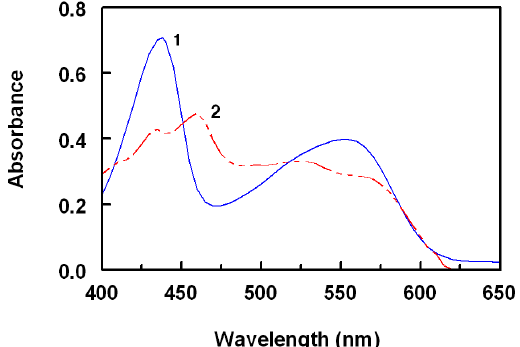
Figure 3. Absorption spectra of the CT complexes of ROS-Ca with TNB (1) and DDQ (2) Concentrations of ROS-Ca were 50 and 15 μ g mL − 1 in case of TNB and DDQ, respectively. Solutions were prepared in acetonitrile for reaction with TNB and in methanol for reaction with